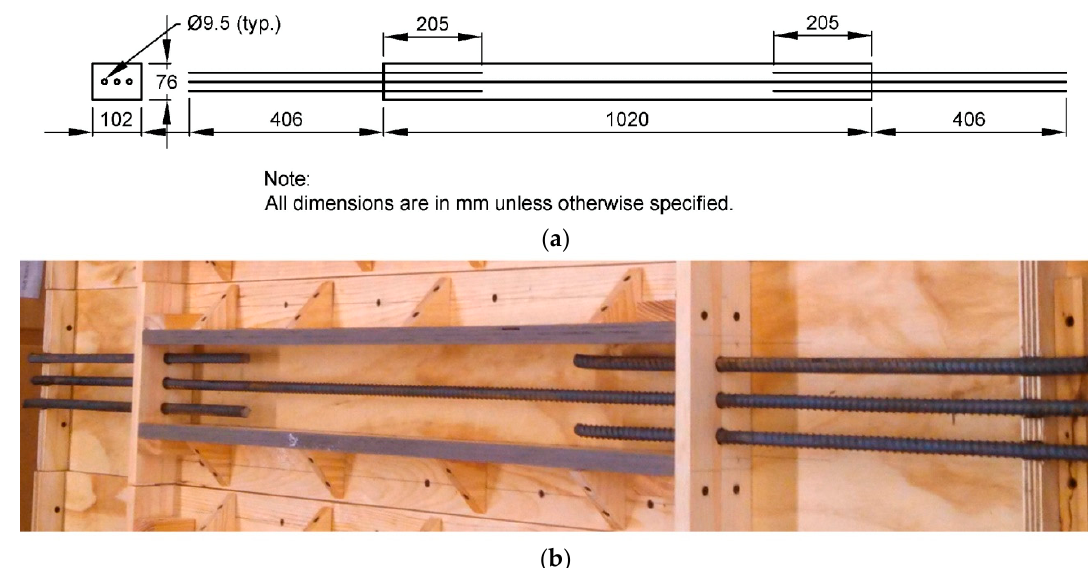
Figure 10. Specimen preparation: ( a ) Line sketch of the specimen; ( b ) Assembled mold.